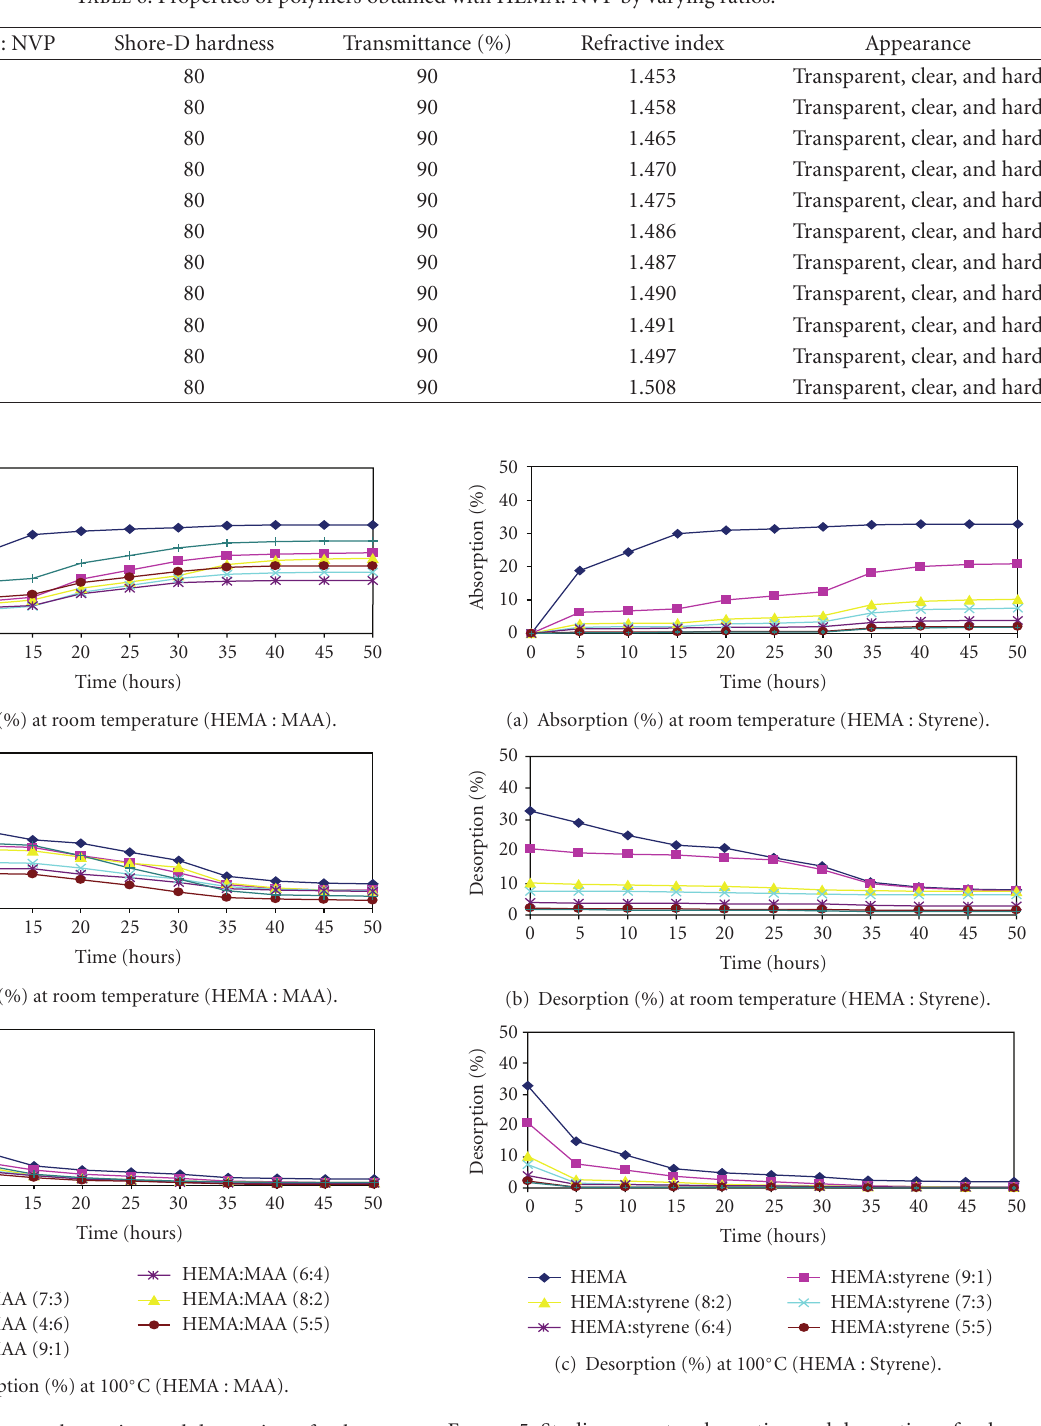
Figure 4: Studies on water absorption and desorption of polymers obtained with HEMA : MAA.